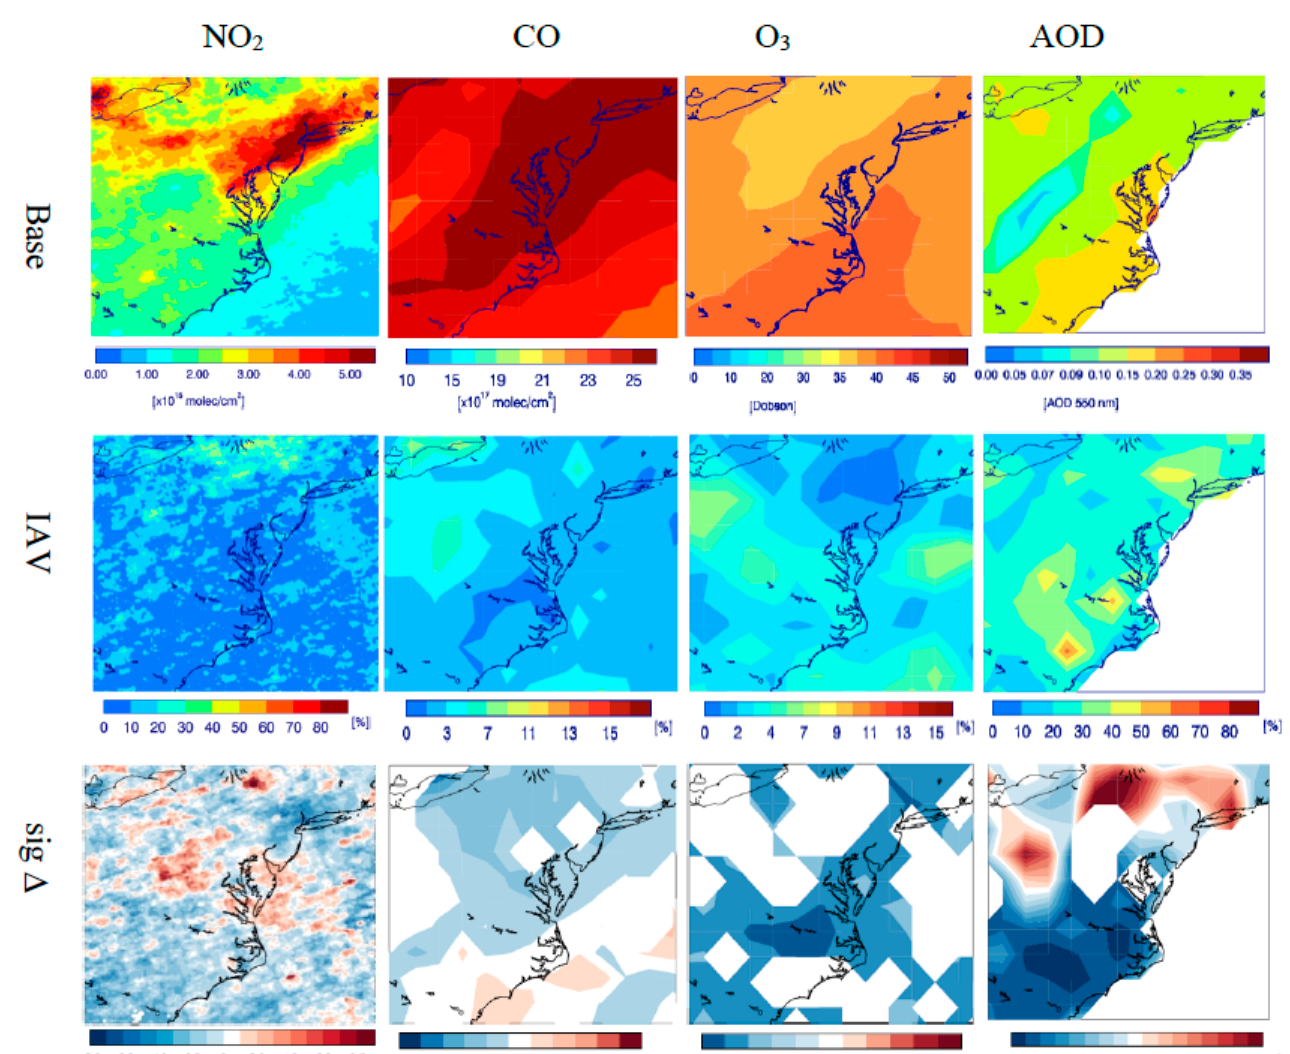
Figure 4. Same as Figure 3, but for the northeastern US. O 3 levels increased from north to south over this region (toward higher temperature and solar radiation) with O 3 tropospheric column (TCO) measuring 35 DU over NY and NJ and 40 DU to the south (on Virginia and North Carolina), see Figure 4. O 3 IAV was very low, reaching ~2% over NY, NJ, and DE. TCO was reduced by 15% in this region, which, given the small IAV in NYC, shows that the reduction of traffic volume in NYC was effective in improving AQ (ETR~13%). The decrease in O 3 over NYC was also evident in the ozone IAV time series (Figure 6). No significant O 3 changes could be seen over WV or PA (blank areas in Figure